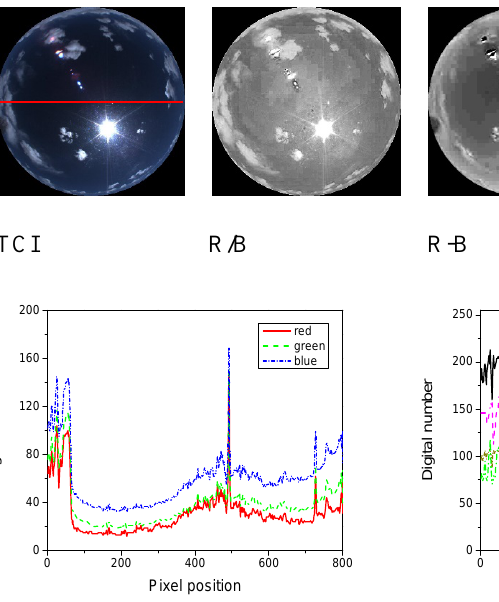
Figure 3. Same as Fig. 2 but with visible sun.